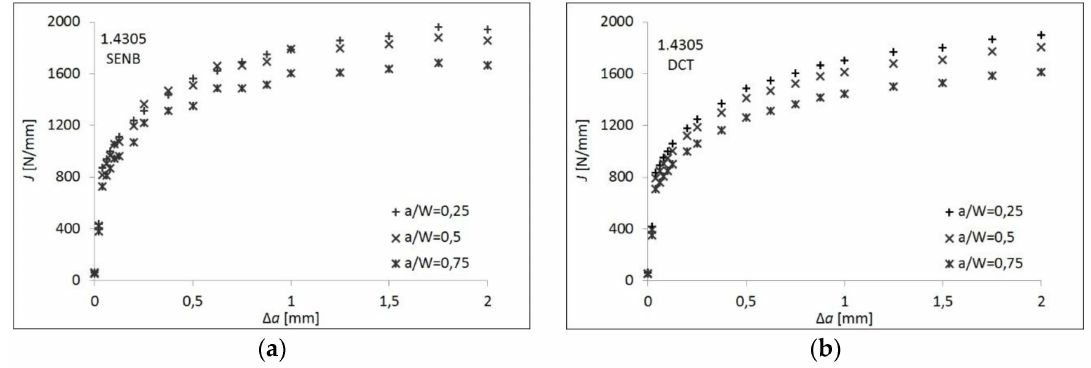
Figure 7. Numerically-predicted J values for steel 1.4305 using FE models of: ( a ) SENB specimen; ( b ) DCT specimen.